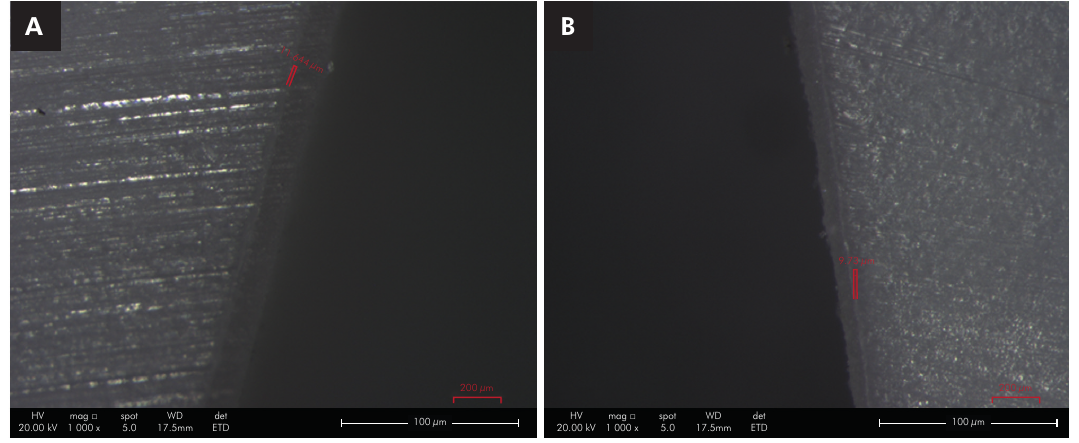
Figure 3. a) Glaze layer thickness of the GS group (11.64 μ m) and b) the GP group (9.73 μ m) observed in SEM using 1000×